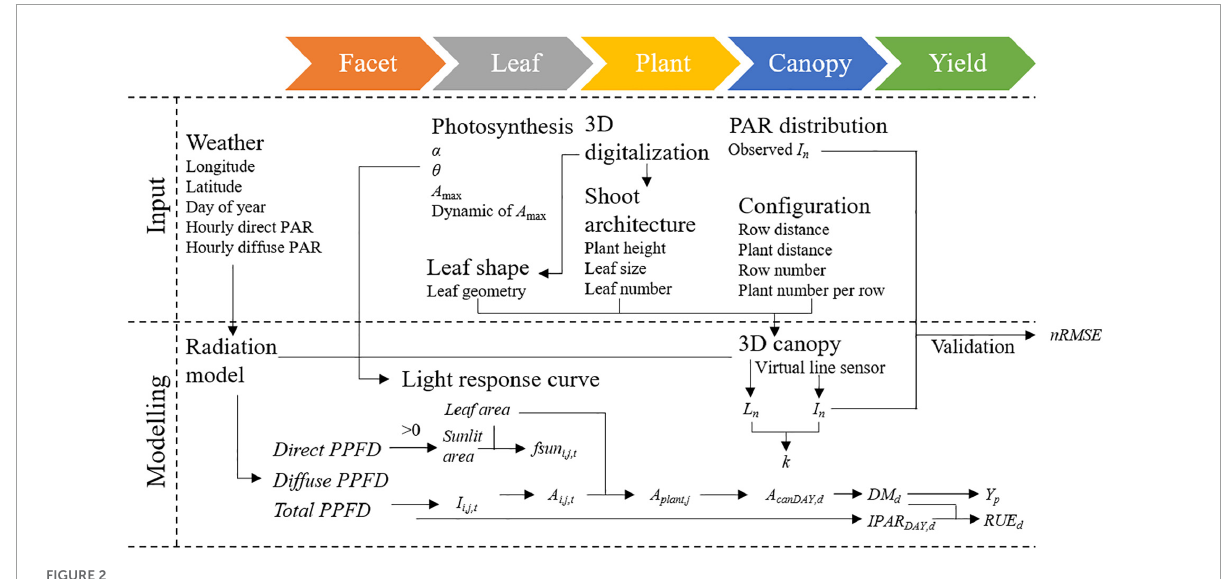
FIGURE2 Workflow diagram of the 3D